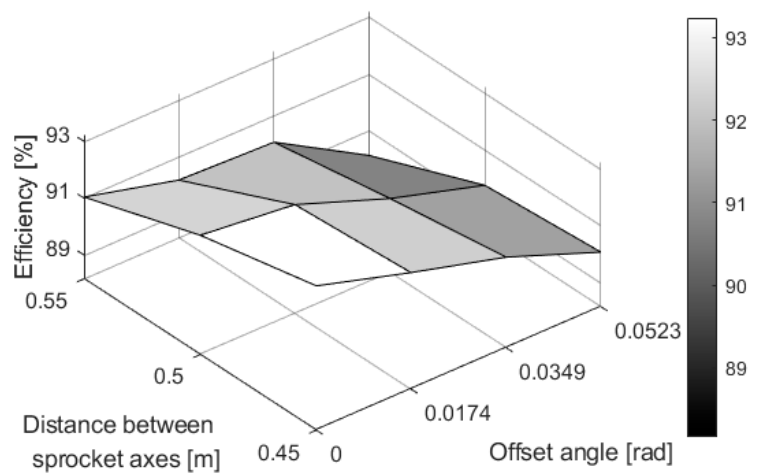
Figure 13. Chain drive e ffi ciencies for di ff erent center distances between sprockets with an o ff set